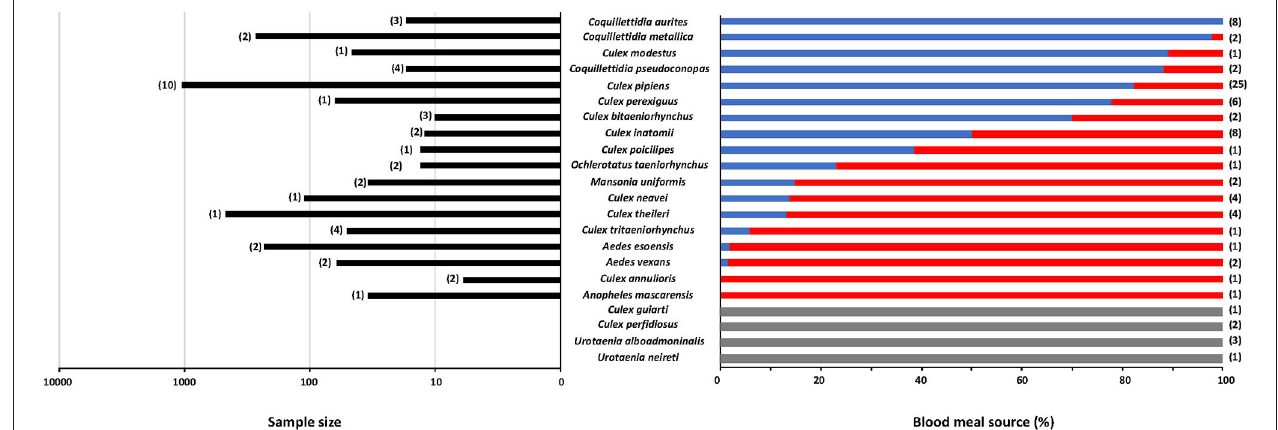
FIGURE 2 | Percentage of bird (blue) and mammal (red) derived blood meals from female mosquitoes species that have shown avian malaria parasites. Mosquito species without information about their blood-feeding behavior are represented in gray ( N = 4). Numbers in bracket on the right represent the number of different lineages isolated in the head-thorax of each mosquito species. Sample size (log-transformed) of each mosquito species analyzed is shown in black. Numbers in brackets on the left represent the number of studies (see Supplementary Table 1 ) that have analyzed blood meals in each mosquito